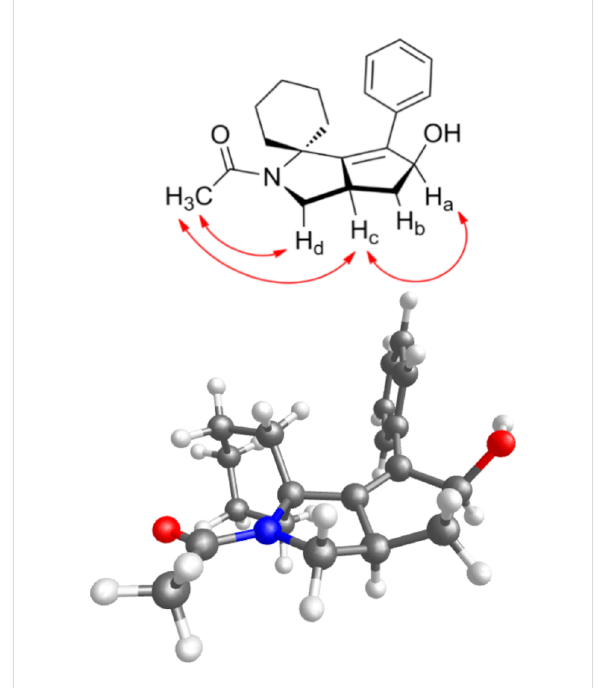
Figure 2: Top: Selected NOE contacts from NOESY 1D spectra of compound 36 ; bottom: low energy conformer of 36 , Z rotamer, using ab initio calculation at the HF/3-21G*